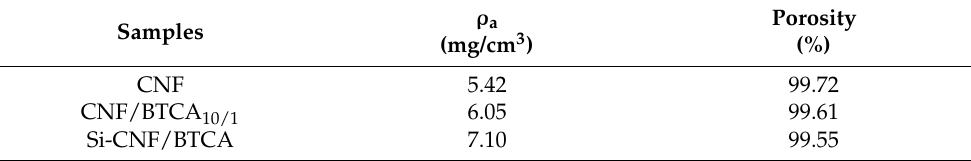
Table 1 . Details of apparent densities ( ρ a ) and porosities of the aerogels . Table 1. Details of apparent densities ( ρ a ) and porosities of the aerogels. Samples